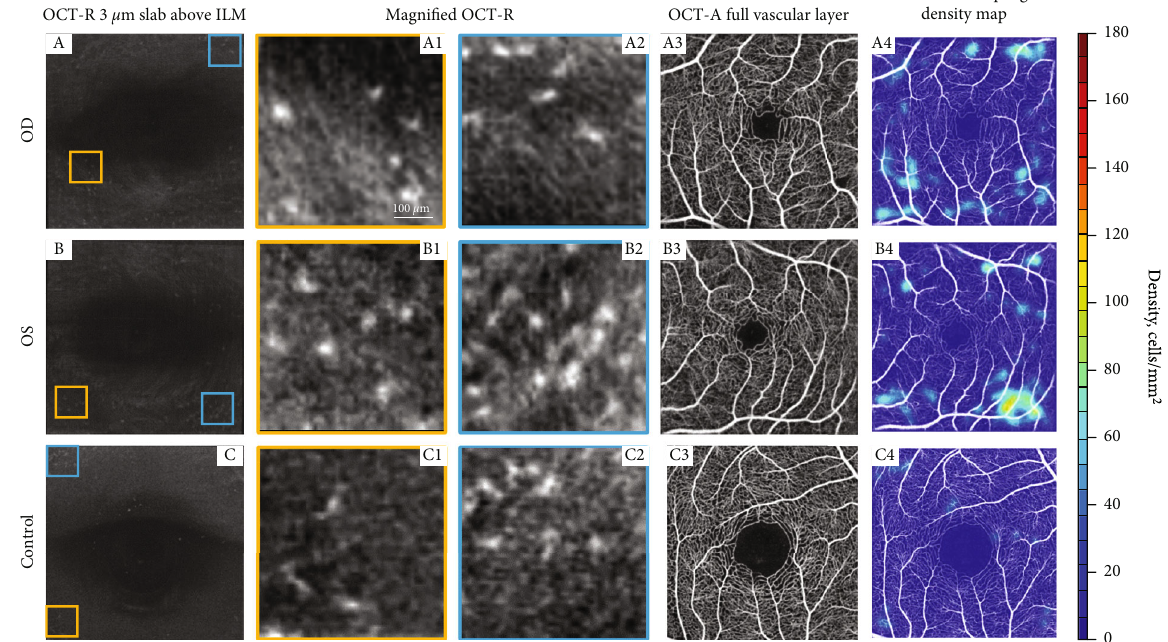
Figure 3: Surface hyalocyte distribution and morphology in right and left eye in our patient with AMN compared to 35-year-old healthy control, using en face OCT. (a – c) OCT-re fl ectance slab segmented 3 μ m above the ILM surface shows higher density of surface macrophage cells in eyes with AMN (more apparent on A4, B4, and C4). Orange and blue outlined images correspond to two di ff erent regions of interest with magni fi ed view of surface macrophages (A1 – C2). (A1 – C2) Magni fi ed view of surface macrophages in right and left eye in our patient with AMN and a healthy control. In the eyes with AMN, the cells appear round with fewer, shortened processes, consistent with in an “ activated ” state. In the healthy control, there are fewer cells and they appear slender with spindle- or star-like con fi guration consistent with a “ quiescent ” state. (A3, B3, C3) OCT-A full vascular layer of right and left eye in our patient with AMN and a healthy control. (A4, B4, C4) Overlay of hyalocyte density map onto the OCT-A. Surface hyalocyte density increases in acute ischemic conditions such as AMN. Cell density: AMN eyes, OD 9.26 cells/mm 2 , OS 10.38 cells/mm 2 , and control eye: 2.39 cells/mm 2